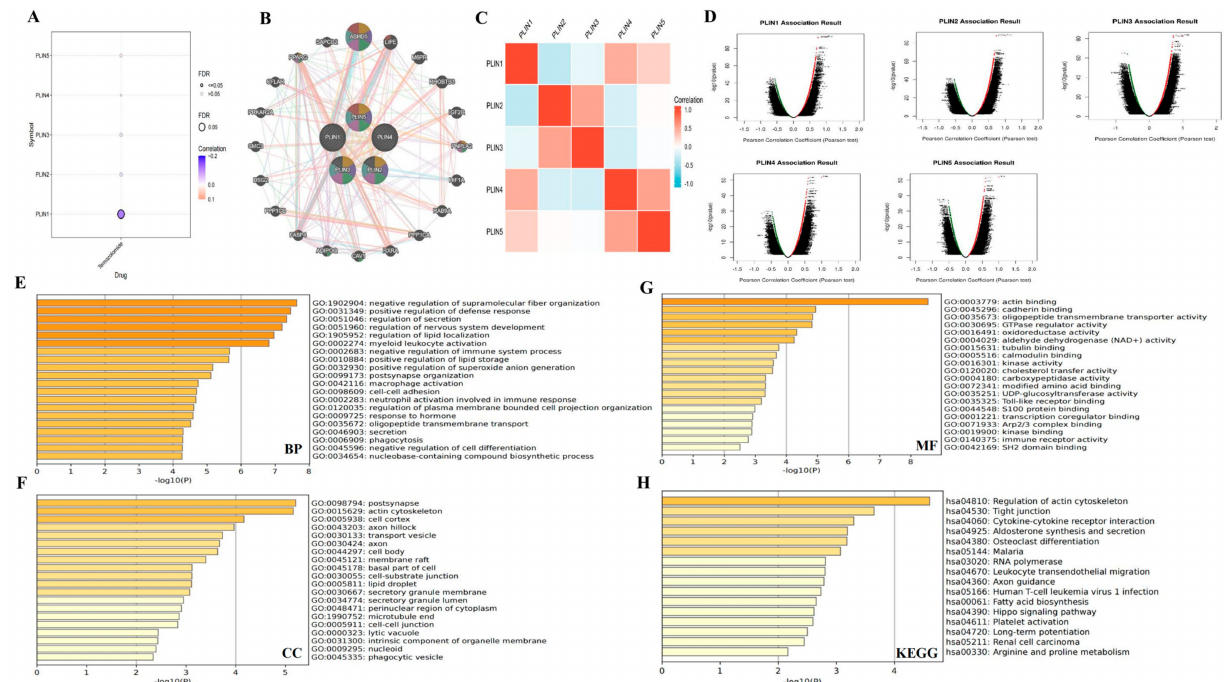
Figure 9. Analysis of drug sensitivity-associated genes and biological functions of PLINs family. ( A ) Drug sensitivity analysis of PLINs family. ( B ) The PLINs gene interaction network and related functions were obtained by GenMANIA analysis. ( C ) Heat map of the correlation between the members of the PLINs family. ( D ) Volcano maps of PLINs family members with co-expressed genes in LGG. ( E – H ) GO enrichment of PLINs family members in LGG and KEGG pathway analysis. GO: Gene